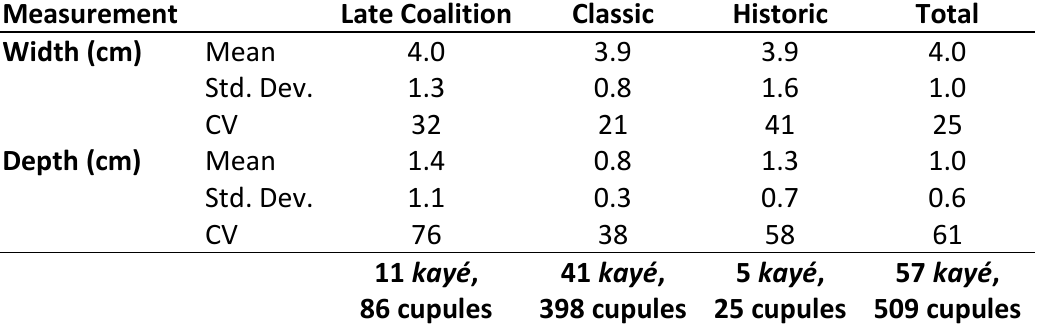
Table 4. Measurements of width and depth between kayé rock